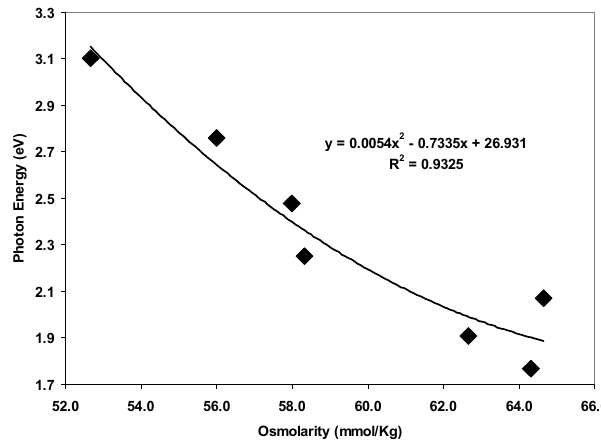
Figure 5B: Mathematical Relationship between photon energy and osmolarity of different E-waters Second, the effect of E-water on T cell proliferation was assessed. T cells in media alone and in the presence of P, are considered as base value (Figure 6). While most E-water tests showed some degree of suppression of T-cell proliferation, E-blue showed complete inhibition of PHA stimulated T cell proliferation. The viability of cells was (cid:1) 90% in all conditions as measured by trypan blue, suggesting that the inhibition in proliferation was not due to some toxic reagent.